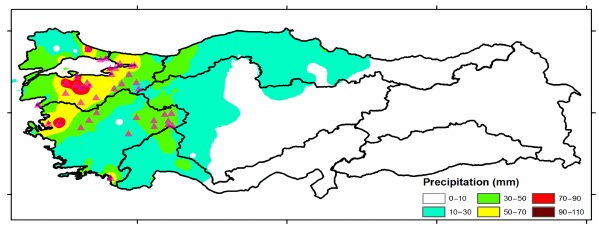
Figure 4. Daily total precipitation amounts over Turkey on 28 Octo- ber 2010 (mm, in shaded) and the stations exceeding their 90th per- centile threshold